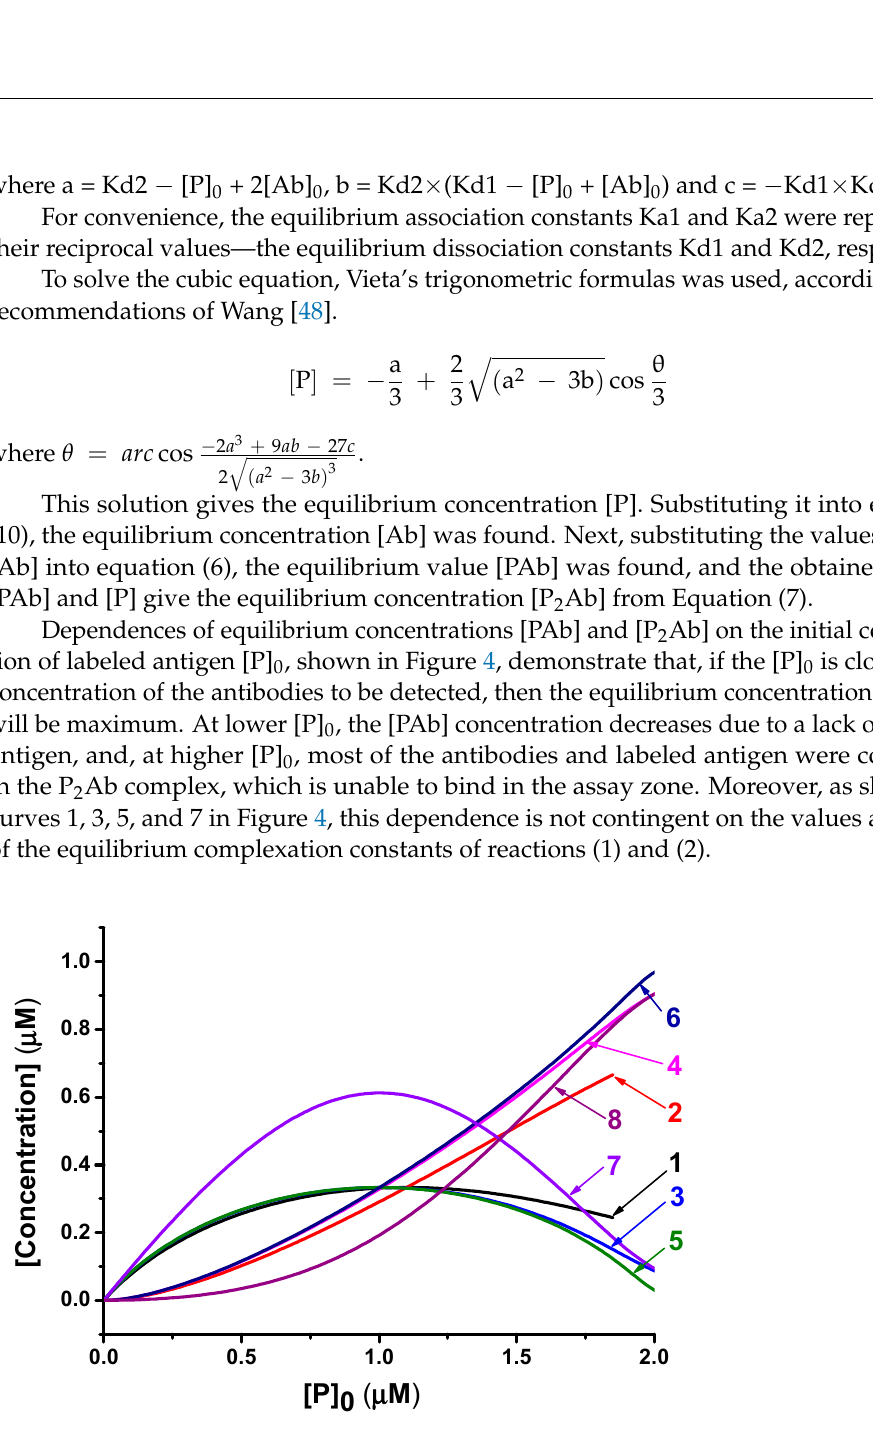
Figure 4. Equilibrium concentrations of PAb and P 2 Ab complexes. Model parameters: [Ab] 0 = 1 μ M; 1. [PAb] at Kd1 = Kd2 = 0.1 μ M; 2. [P 2 Ab] at Kd1 = Kd2 = 0.1 μ M; 3. [PAb] at Kd1 = Kd2 = 0.01 μ M; 4. [P 2 Ab] at Kd1 = Kd2 = 0.01 μ M; 5. [PAb] at Kd1 = Kd2 = 0.001 μ M; 6. [P 2 Ab] at Kd1 = Kd2 = 0.001 μ M; 7. [PAb] at Kd1 = 0.001 μ M, Kd2 = 0.01 μ M; 8. [P 2 Ab] at Kd1 = 0.001 μ M, Kd2 = 0.01 μ M.